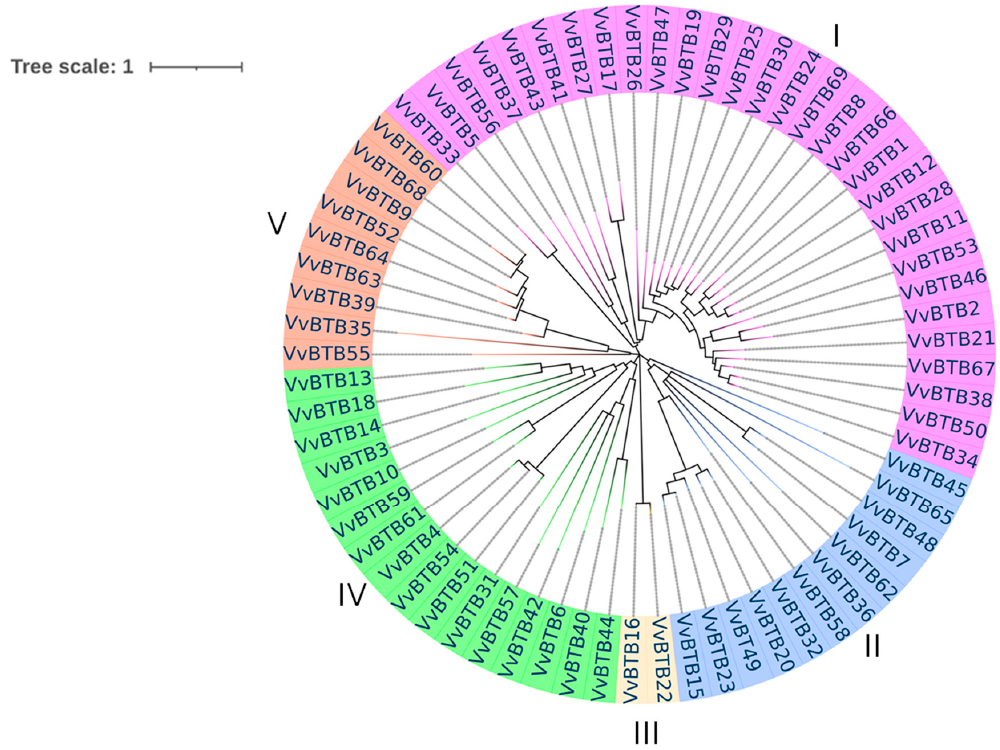
Figure 2. Phylogenetic tree of BTB gene family. The maximum likelihood tree was generated using protein sequences of 69 BTB genes of V. vinifera . Different colors show five different groups. Pink color: group I; blue color: group II; light-yellow color: group III; green color: group IV; red color: group V.